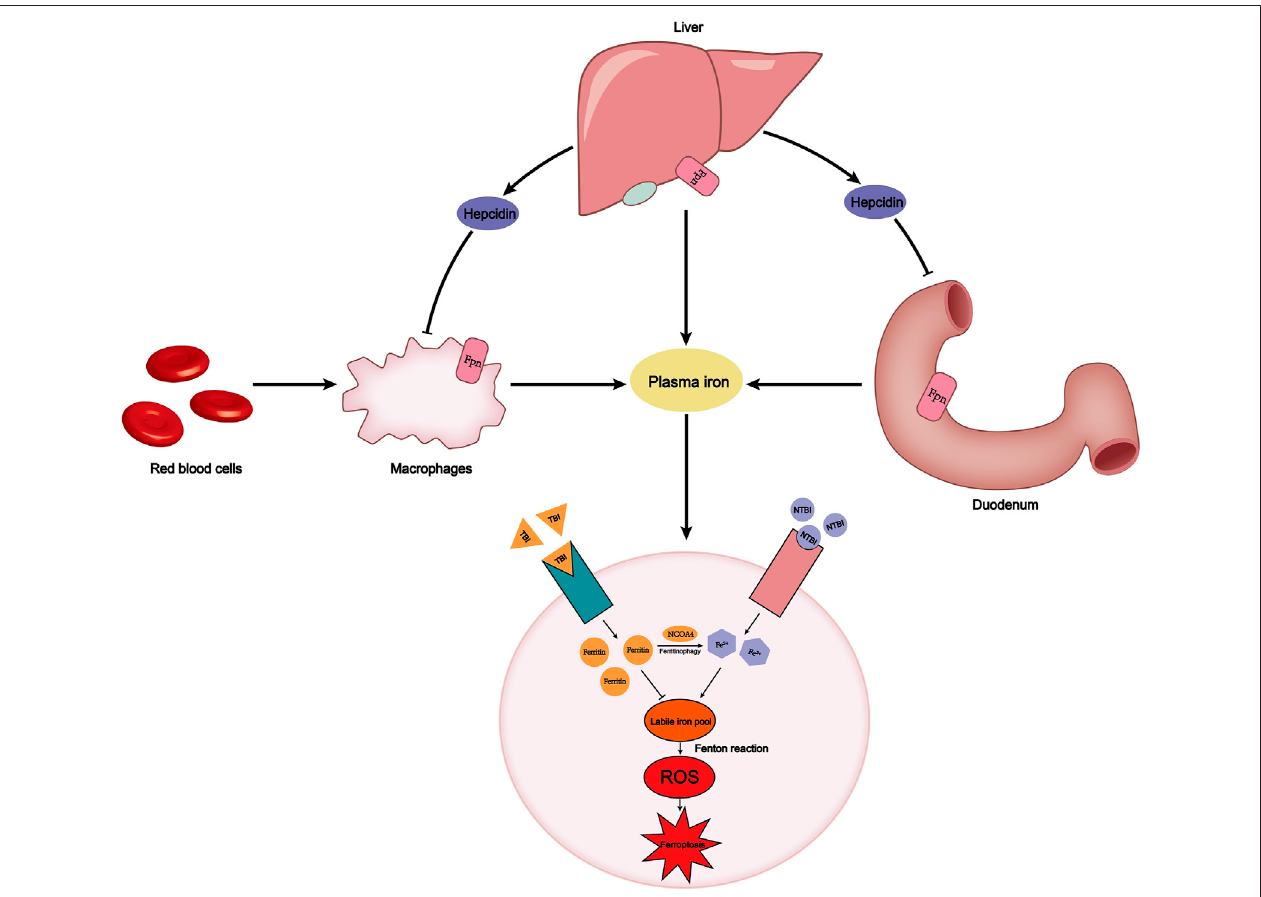
FIGURE 1 | Plasma iron concentration is always maintained within a certain range. This relies on the precise dynamic balance of iron metabolism. FPN on the surface of macrophages, the duodenum, and liver transports iron into the plasma. The endogenous source of iron is mainly hemoglobin iron that is swallowed by macrophages,whiletheexogenoussourceisironinfoodabsorbedbytheduodenum.HepcidinsecretedbythelivercandegradeFPNtoreduceironexport.Plasmairon is divided into TBI and NTBI according to whether it binds to transferrin. TBI binds to the TfR1 on the cell membrane surface and stores iron in the form of ferritin, avoiding the occurrence of Fenton reaction. However, labile iron pool, derived from NCOA4-mediated ferritinophagy or NTBI absorbed by SLC39A14, will cause an increase in intracellular ROS and ferroptosis. FPN, ferroportin; TBI, transferrin-bound iron; NTBI, non-transferrin-bound iron; TfR1, transferrin receptor.